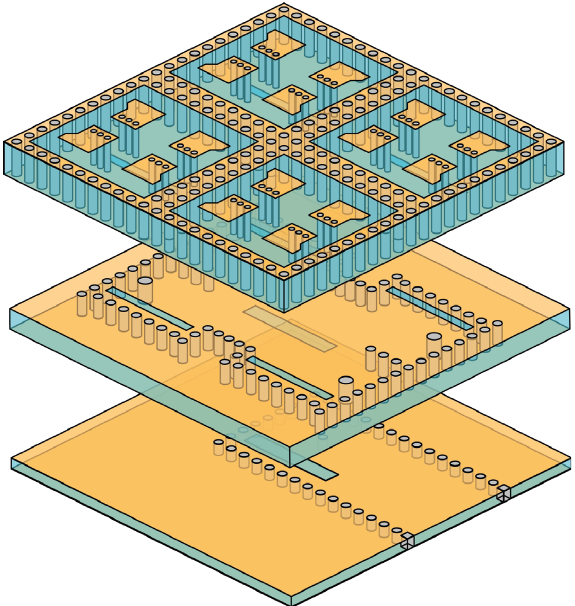
Figure 8: 3D exploded view of the proposed 2 × 2 subarray. Table 3: Dimensions of 2 × 2 subarray (unit: